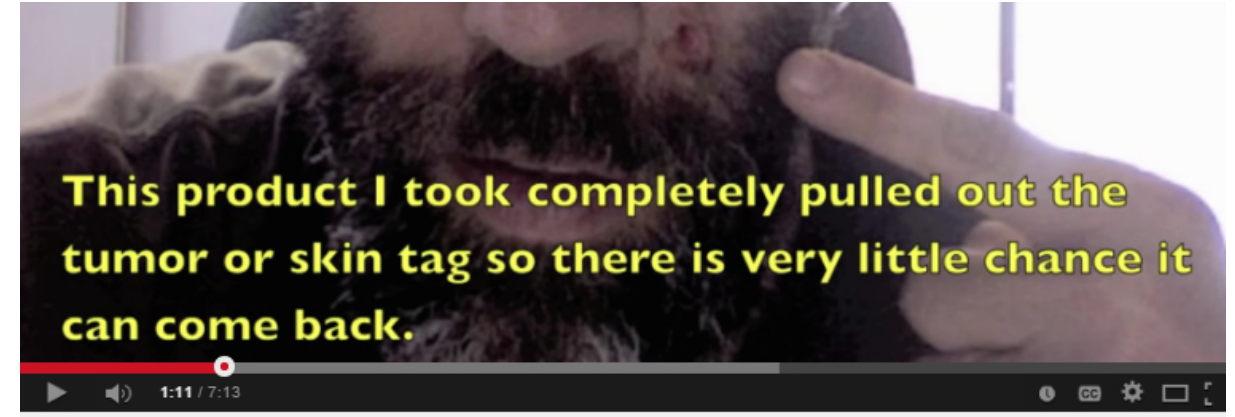
Figure 2. Screenshot of tumor